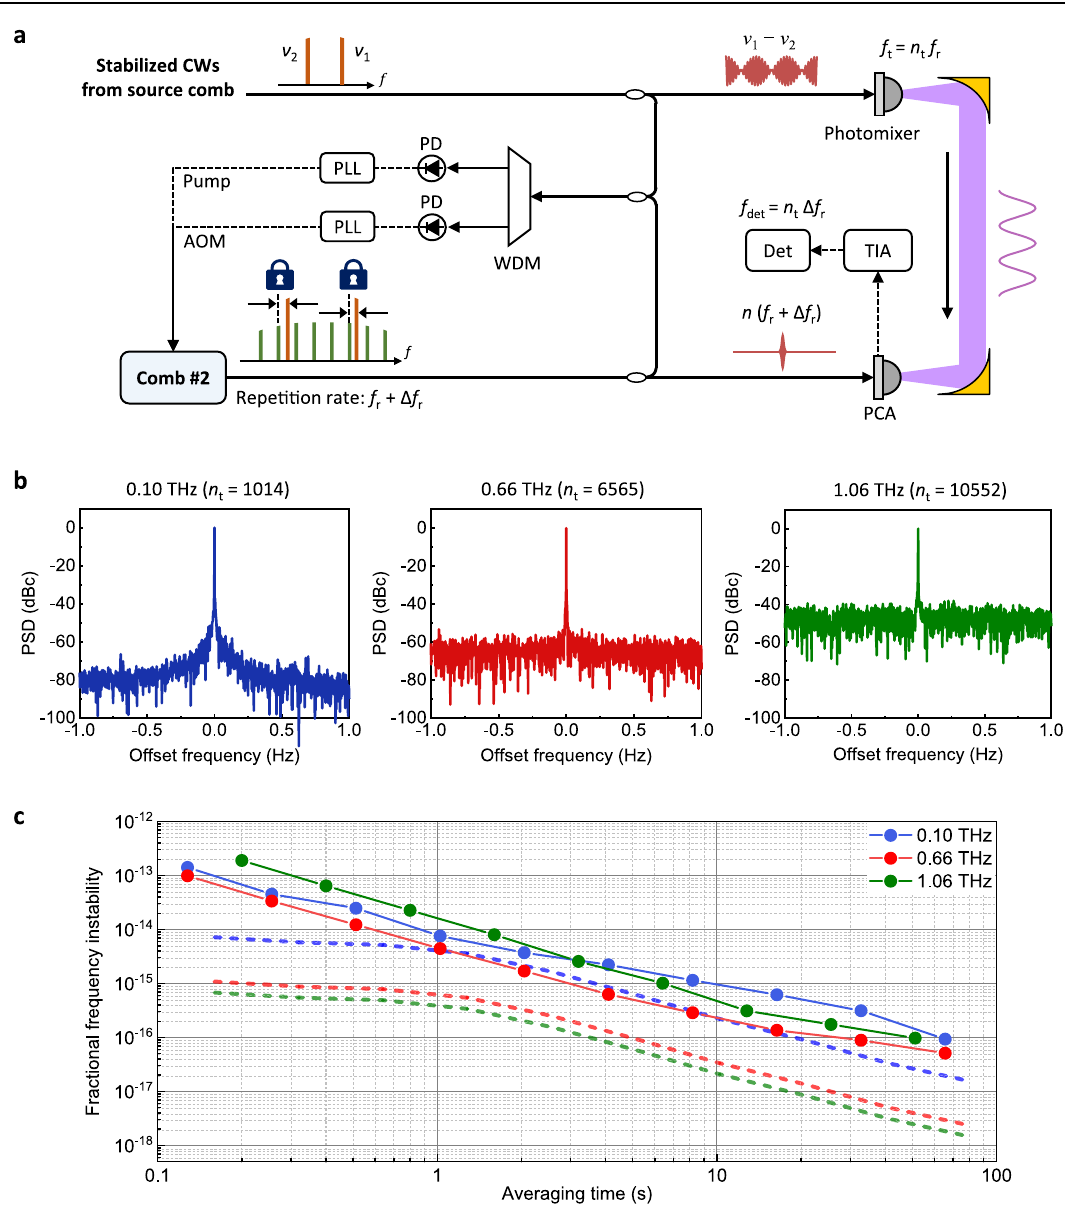
Fig.3|Absolutedeterminationofterahertzfrequencies.a Measurementscheme employing an extra comb — Comb #2. b Power spectral densities (PSDs) of gener- ated terahertz frequencies. c Allan deviations of generated terahertz-frequencies. Dashed lines are the ideal values estimated purely from the optical phase noise of